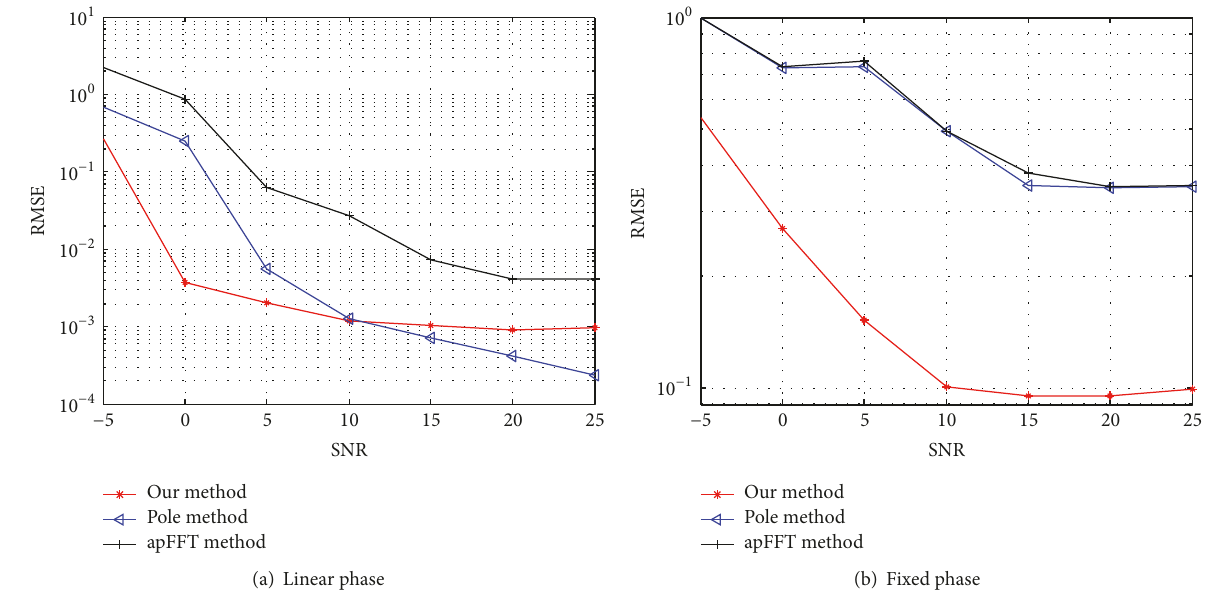
Figure 6: Average RMSE comparison at different